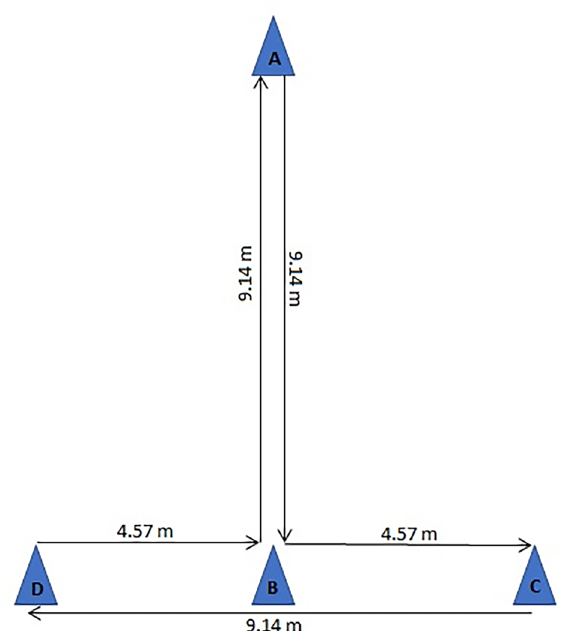
Figure 2. Diagrammatic representation of agility T